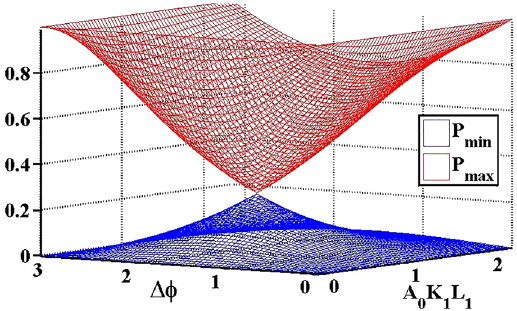
Figure 3. Surface plot of the extremes of the non-reciprocity parameter with different structure